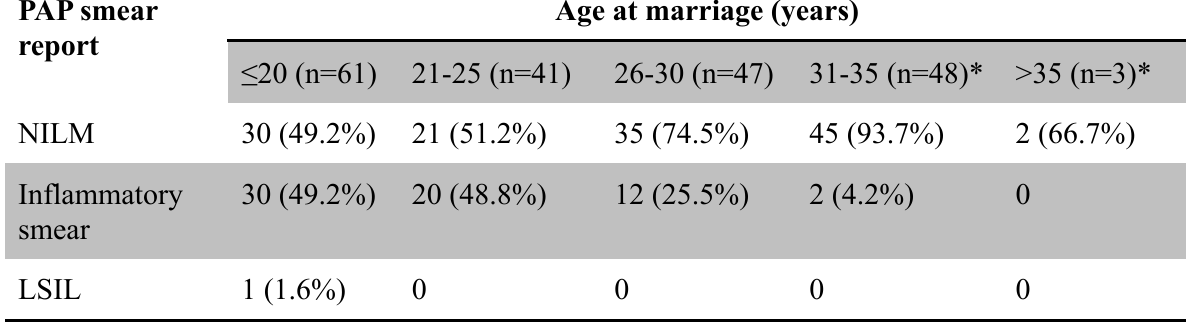
Table 3: Distribution of the study participants based on their age at marriage and the PAP smear report (N=198) PAP smear